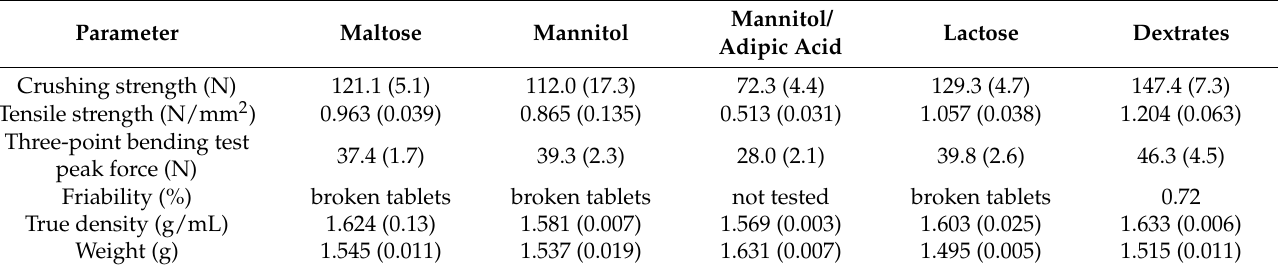
Figure 5. Tablet hardness: crushing strength was measured, and the three-point bending test was performed for each formulation ( n =10). Tensile strength was calculated from the results. Table 3. Tablet hardness characteristics displayed as mean and (SD).